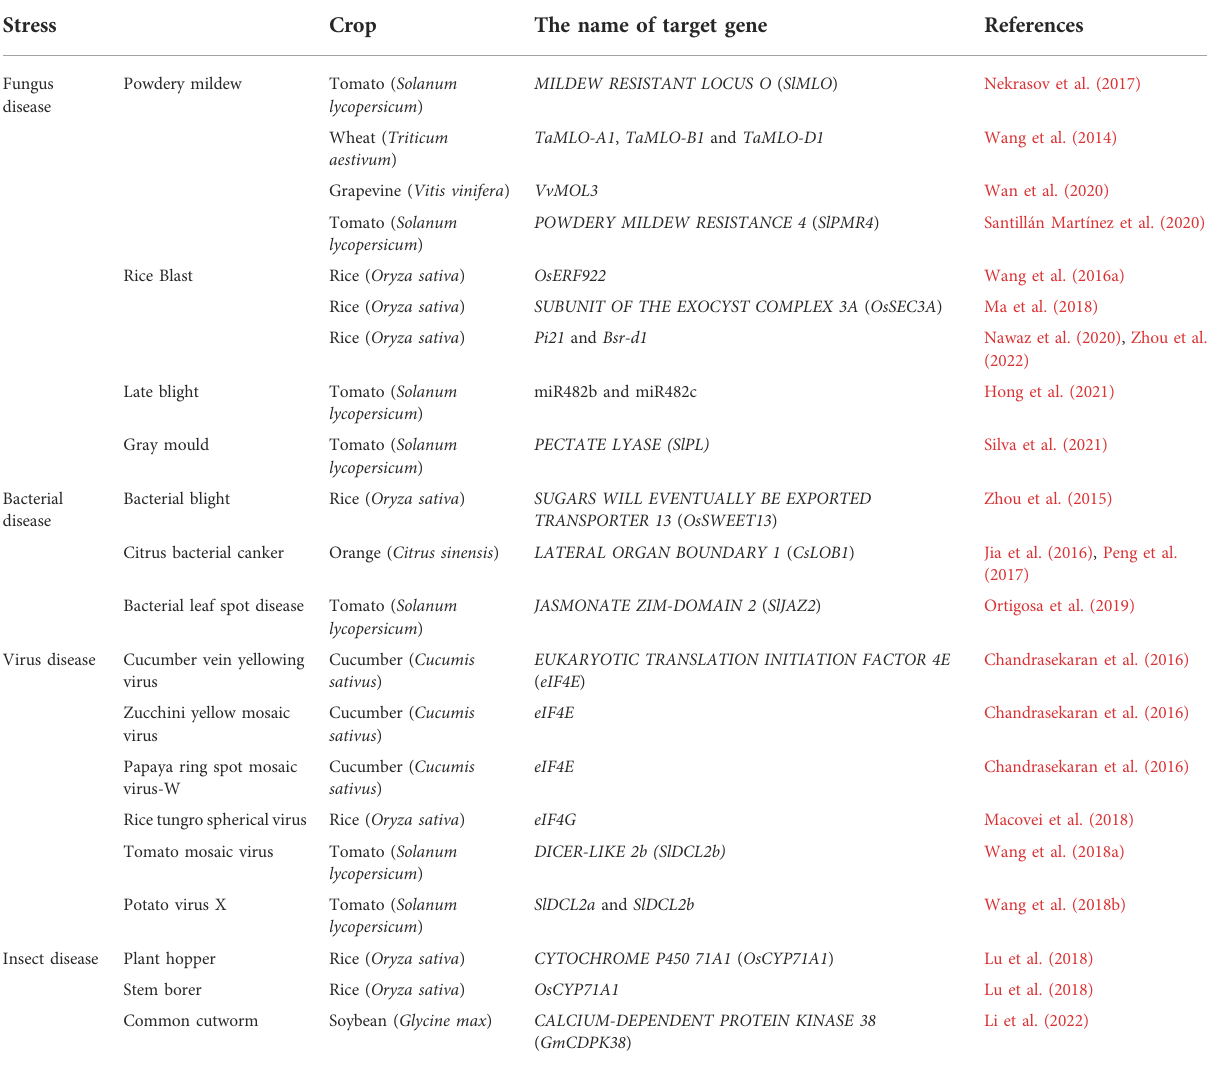
TABLE 2 Genes targeted by CRISPR/Cas for imparting tolerance against biotic